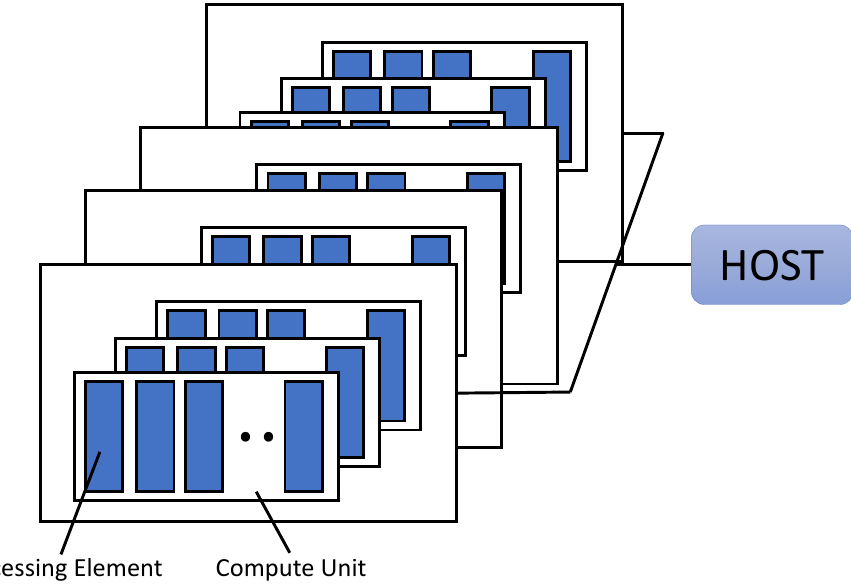
Figure 5. OpenCL platform model